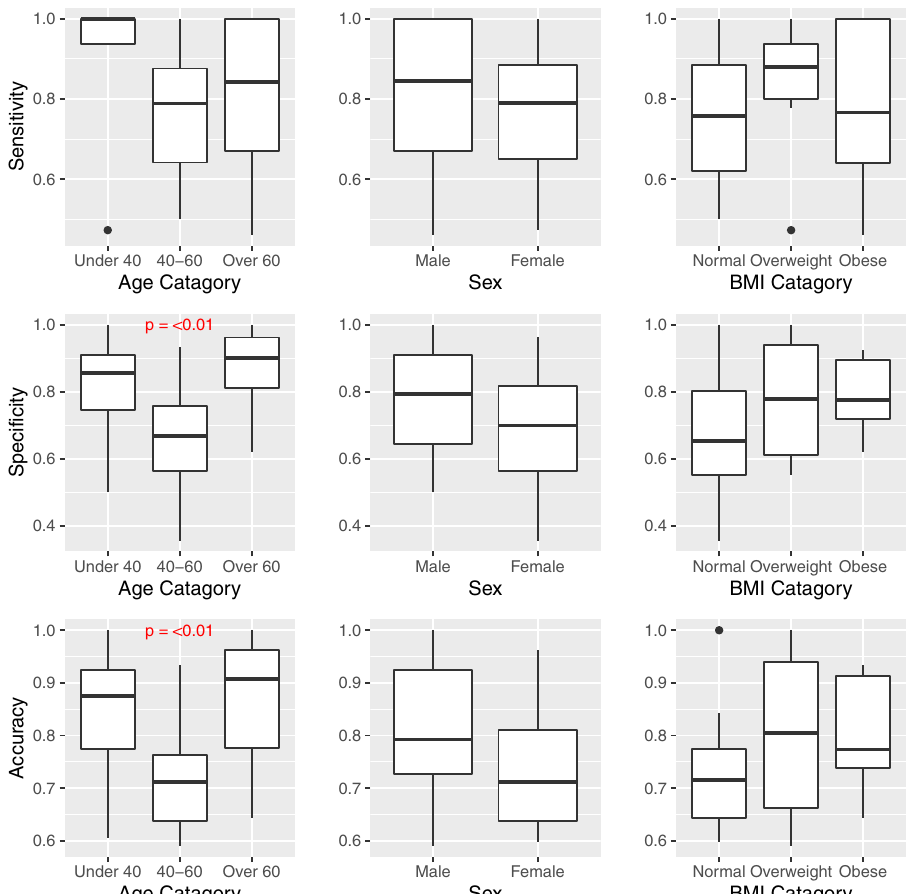
Fig. 3 Model metrics strati fi ed by demographic characteristics. Center line = median; upper bound of box = 75th percentile; lower bound of box = 25th percentile; and whiskers = minimum to maximum range, with extreme outliers denoted by black dots. P value based on Kruskal – Wallis H test. BMI Body Mass